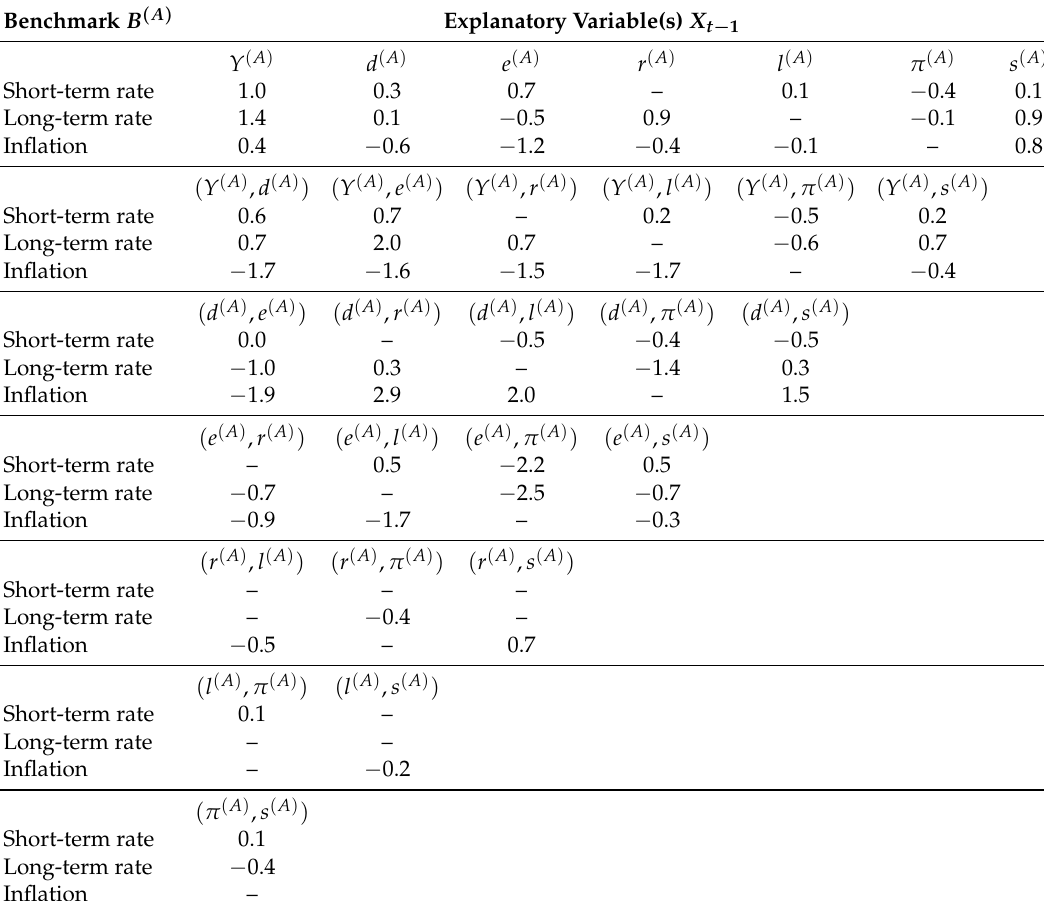
by construction of the transformed V , ν ( R ) ) / ( 1 + r ) − 1 = ( l − r ) / B ( R ) = ( 1 + l t − 1 t − 1 t − 1 t − 1 t − 1 t − 1